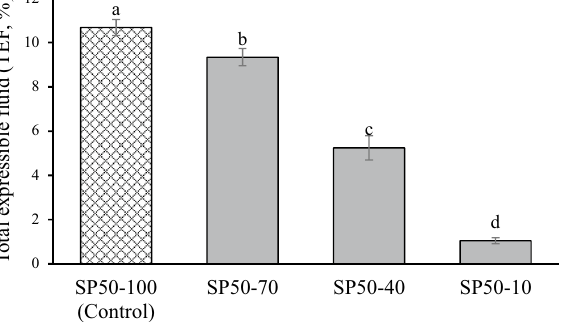
Figure. 5. Total expressible fluid (TEF, %) of chicken bread spread-fortified with 50% of silkworm pupae with different levels of coconut oil. SP50-100 (Control): Chicken bread spread with 50% replacement of chicken by silkworm pupae without fat reduction (100% of coconut fat). SP50-70, SP50-40, and SP50-10: Chicken bread spread with 50% replacement of chicken meat by silkworm pupae using 70, 40, and 10% of coconut oil in control sample, respectively. Different letters on the bars indicate significant differences ( p ≤